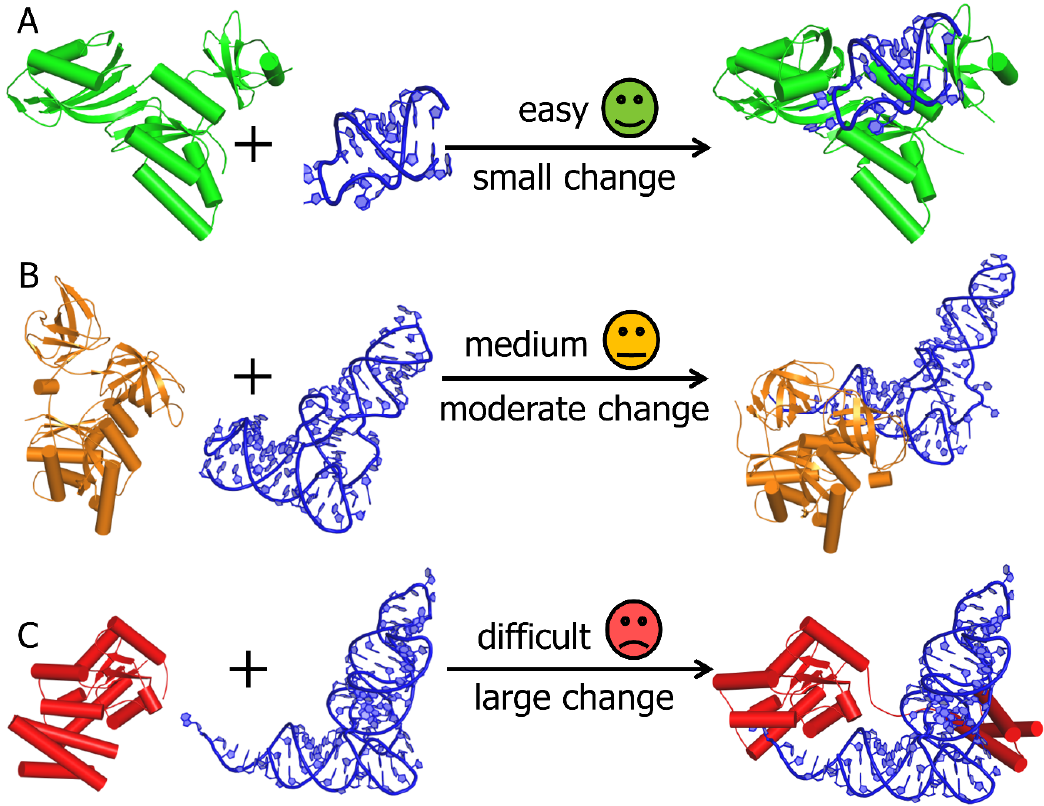
Figure 1. Overview of challenges in RNA-protein (RNP) docking. (A) “easy” docking of